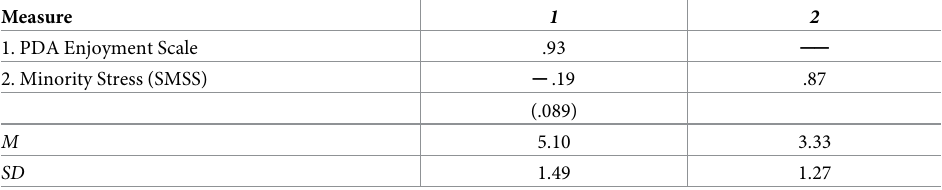
Table 2. Summary of correlations, reliabilities, means, and standard deviations for scores on scales for PDA and minority stress in Study 1.